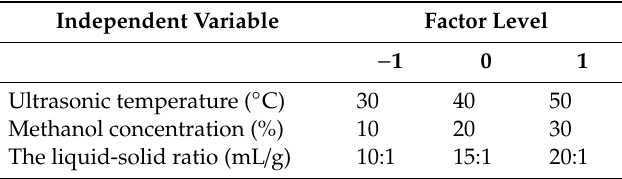
Table 3. Factors Level in RSM experiment.